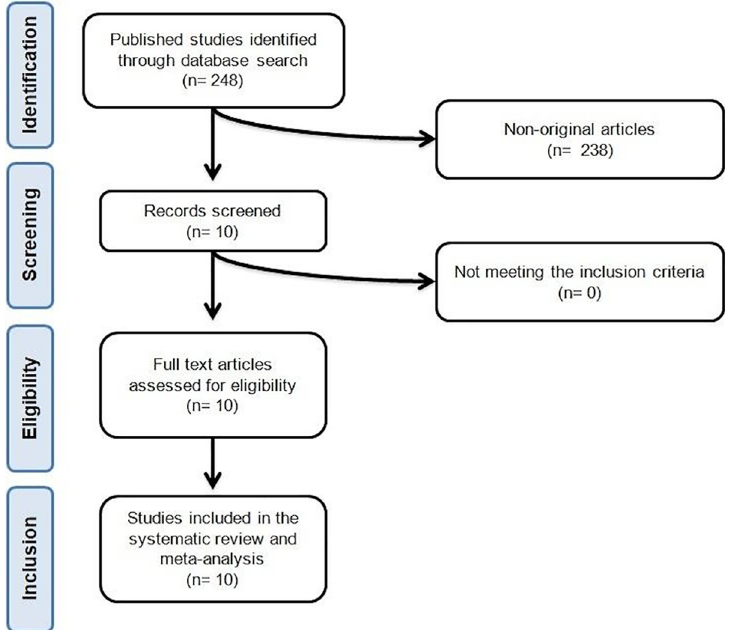
Fig 1. Flow chart of the number of studies identified and included in the meta-analysis. Data were pooled from 10 trials comprising 26 treatment arms, which included overall 3,788 individuals, with 2,460 in the active arm and 1,328 in the control